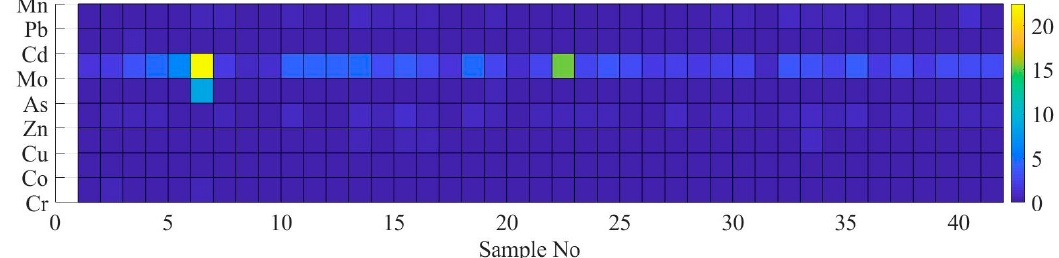
Figure 3. Comparison between the present and literature data on heavy metal concentration. ( a ) Concentration of As; ( b ) Concentration of Cr; ( c ) Concentration of Pb; ( d )